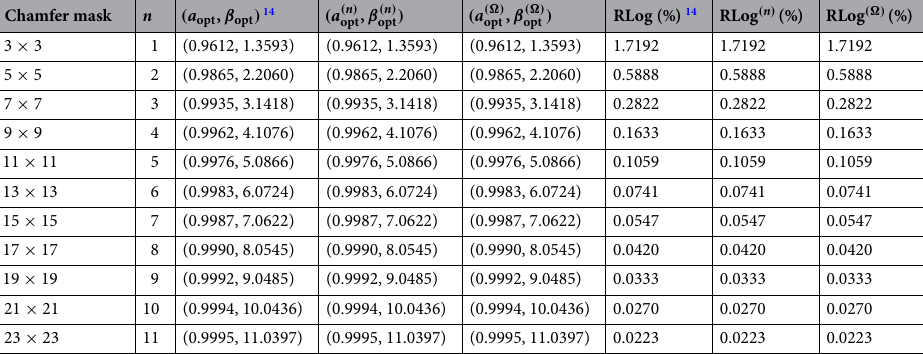
Table 2. Comparisons of optimized chamfer masks. The superscript variables n and (cid:31) reflect computations based on Farey sequences and size of chamfer masks,